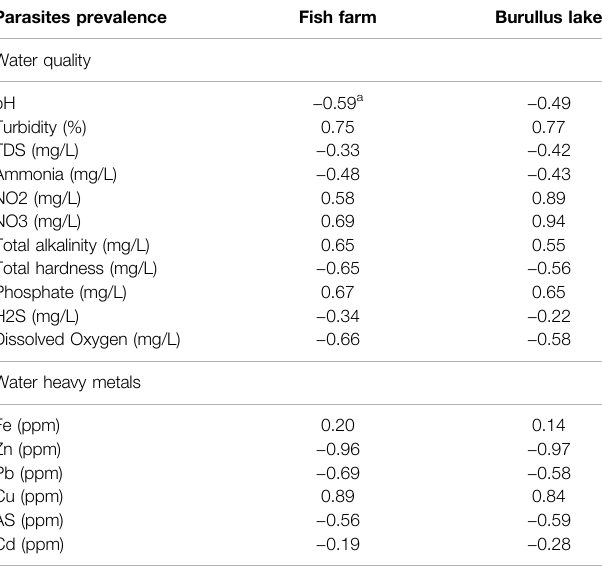
TABLE 6 | Pearson correlation coef fi cients between water quality and water- heavy metals with parasites prevalence of O. niloticus , collected from Fish Farm and Burullus